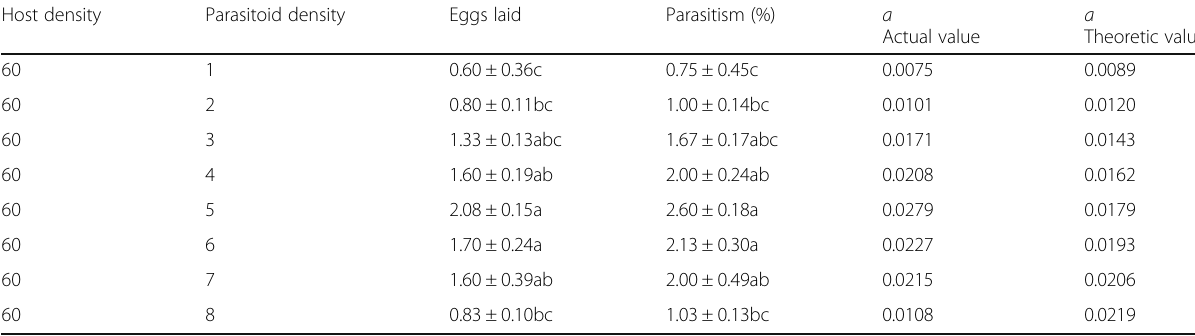
Table 5 Parasitic function of the different density E. bimaculata on Bemisia tabaci nymph (M ±